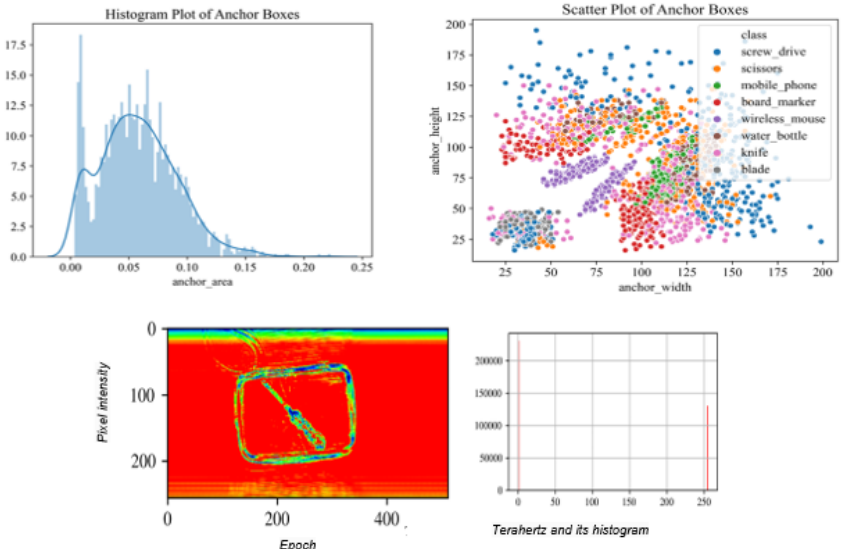
Figure 4. Histogram distribution and scatter diagram of bounding boxes. The sizes of other categories are widely distributed and evenly